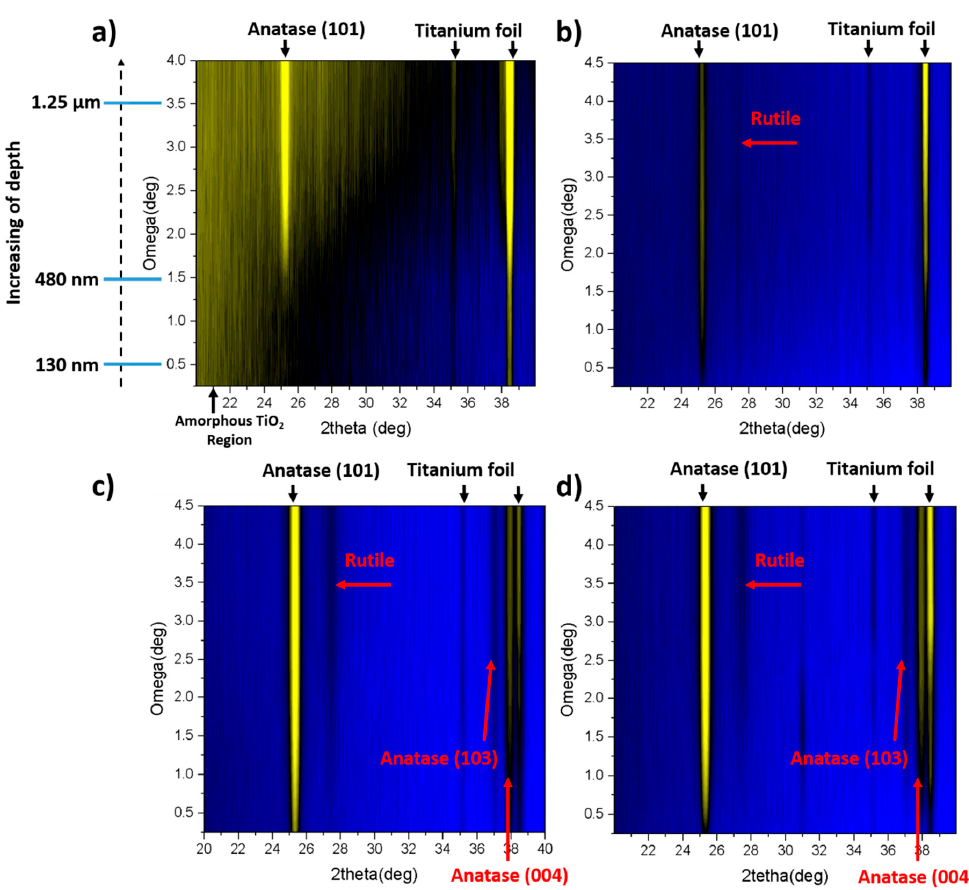
Figure 4. Grazing incident XRD (Gi-XRD) 2-D image scans of amorphous ( a , b ) and calcined ( c , d ) TiO 2 -45 nanotubes annealed by laser in air ( a , c ) and under vacuum ( b , d ).